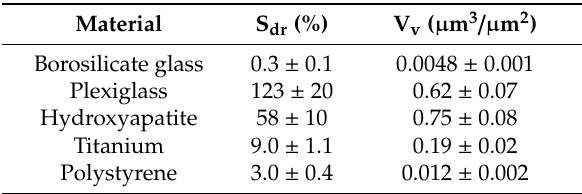
Table 1. Selected roughness parameters of materials used in the assays. S dr describes the relative increase in surface area compared to the flat surface. V v reflects void volume, describing the openness of the surface or surface